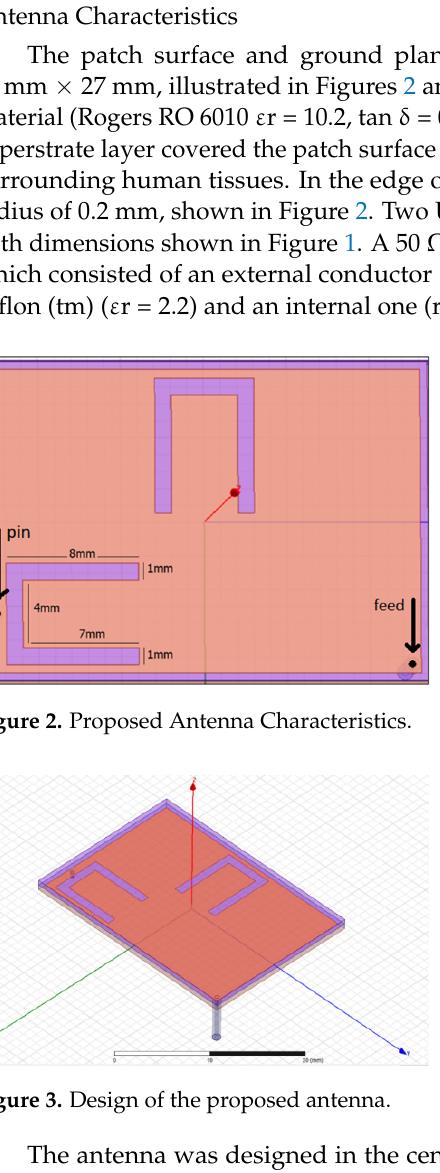
Figure 3. Design of the proposed antenna.